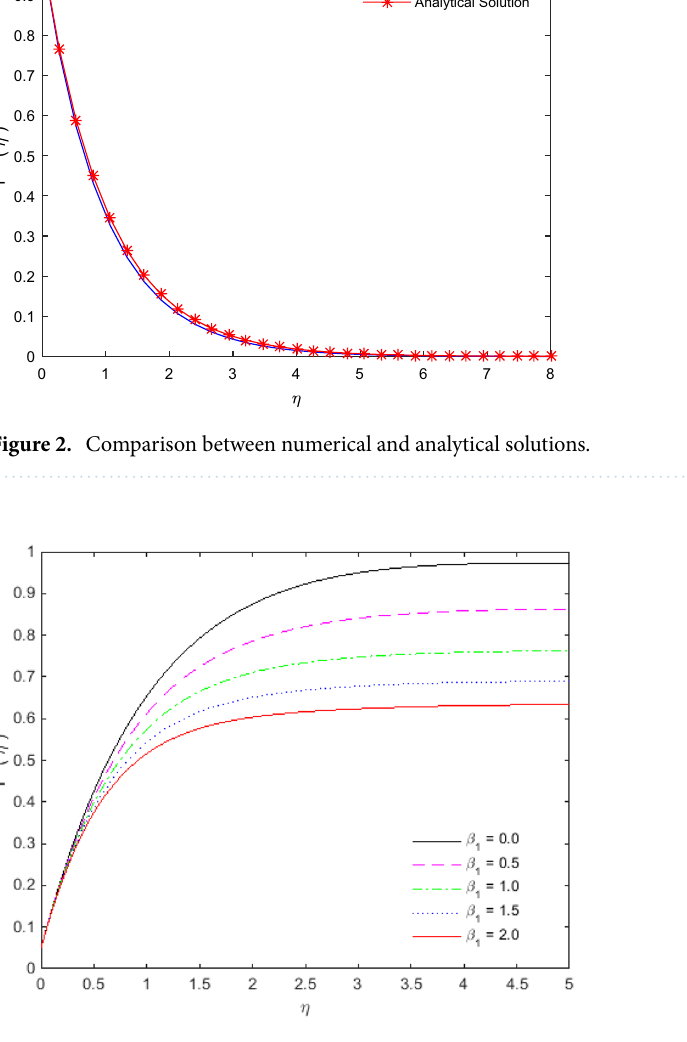
Figure 3. Normal velocity profile for β 1